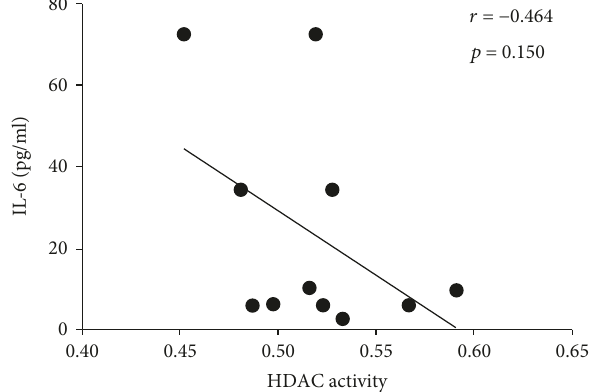
Figure 7: The correlation about IL-6 expression and HDAC activity in RA patients.